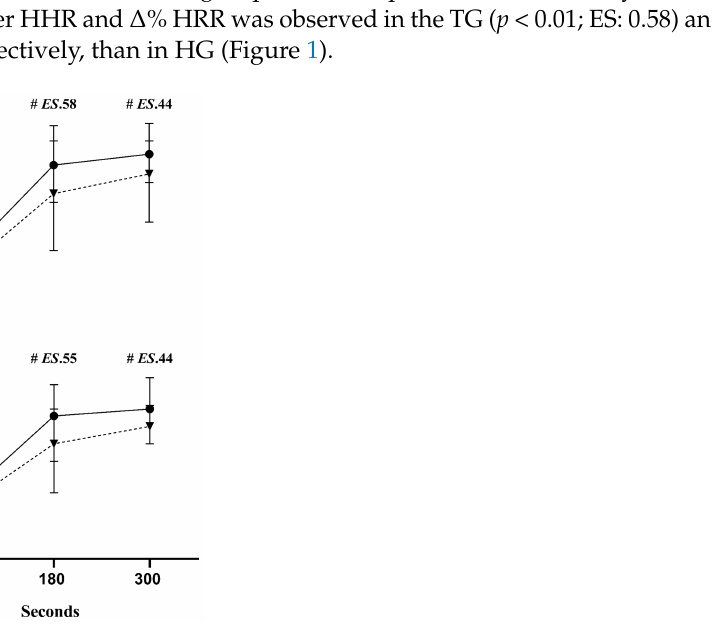
Figure 1. The median (25th, 75th percentiles) of HRR: heart rate recovery and ∆ % HRR at 60, 180, and 300 s. The triathlon group (TG : • ; n = 16, solid line) and the high-intensity interval training combined with different types of exercises group (HG: (cid:72) ; n=18, dashed line) were compared by Mann–Whitney test. # : p < 0.01. ES: effect size. NS: